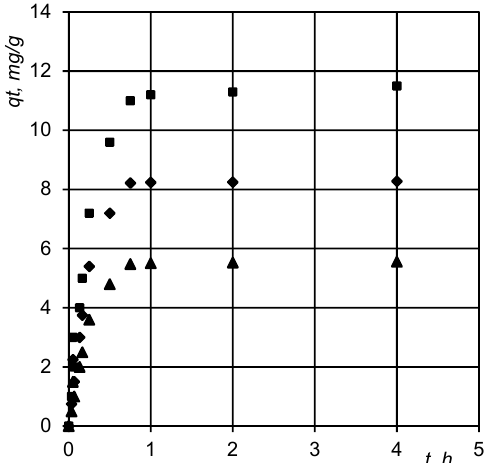
Figure 6. The influence of contact time on diazepam concentration uptake by mineral clay, for different initial concentrations; T = 37.0 ± 0.1 °C; pH = 6.80 ± 0.05; ■ C i = 18 mg/L; ◆ C i = 12 mg/L; ▲ C i = 6 mg/L; and S:L ratio = 1 g/L.